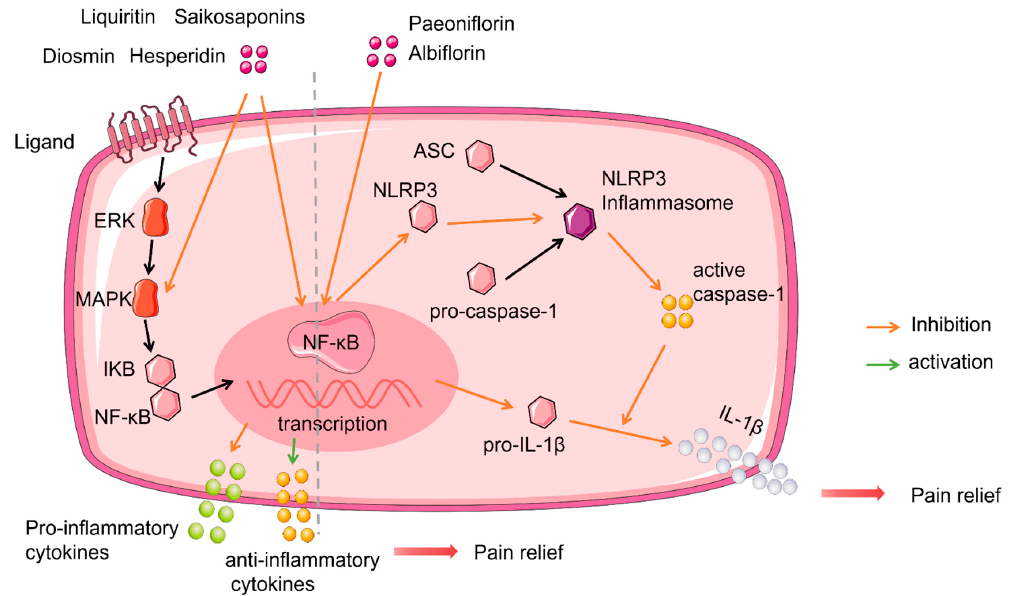
Figure 1. Glycosides and transcriptional regulation. Liquitin, saikosaponins, diosmin and hesperi- din produced relief of neuropathic pain via inhibited NF- κ B transcription downregulated pro-in- flammatory cytokines, upregulated anti- inflammatory cytokines. Paeoniflorin and albiflorin inhib- ited NF- κ B transcription and downregulated the transcription levels of inactive NLRP3 and pro-IL- 1 β contribute to the reduce of NLRP3 inflammasome synthesis, then active caspase-1 cleaved pro- IL-1 β , reduced IL-1 β released, lead to pain relief.